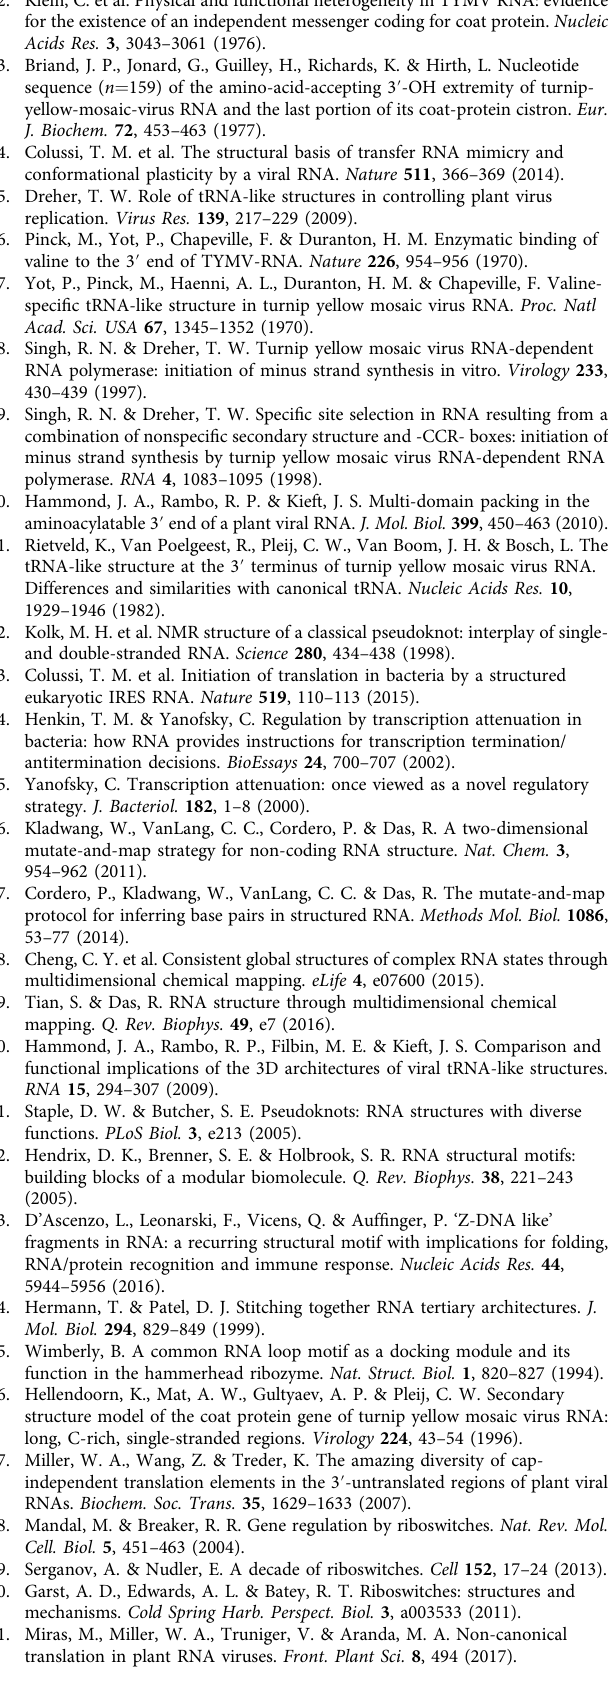
Figure preparation . Structural fi gures were generated using PyMol (The PyMOL Molecular Graphics System, Version 1.8 Schrödinger,